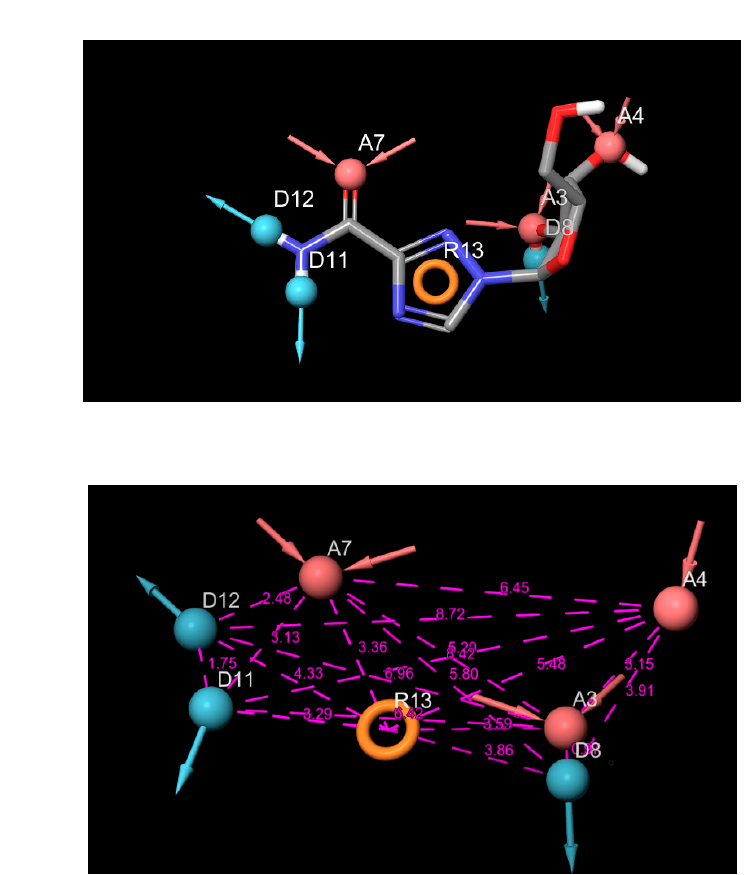
Figure 3. ( A ) Pharmacophore sites generated from the protein data bank structure of murine norovirus RNA-dependent RNA polymerase (MNV-RdRp); ( B ) Distances between the seven pharmacophore sites.